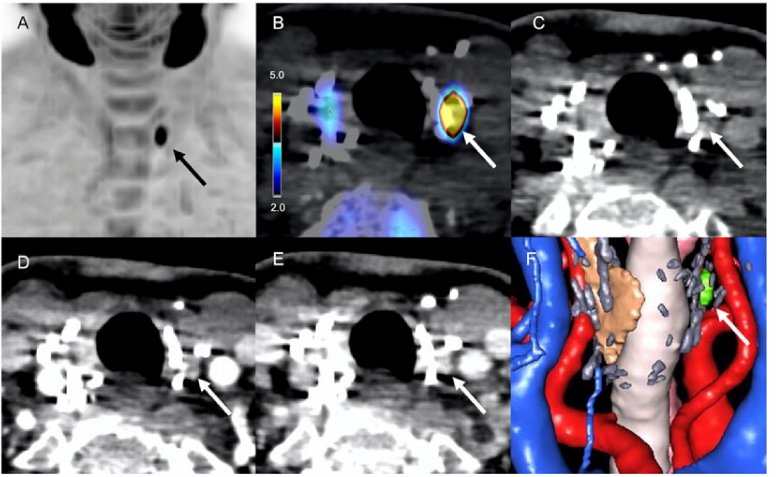
Figure 1. 18 F-FCH PET/CT, 4D-CT and 3D-virtual neck exploration of a 74-year-old woman with recurrent pHPT and a history of left thyroidectomy and removal of the upper right hyperplasic parathyroid gland. From left to right, top to bottom: lower left adenoma (black and white arrows) with high focal accumulation of 18F-FCH (( A ) anterior view of maximum intensity projection, ( B ) axial PET/CT image, SUVmax = 9.67), spontaneous density of 71 HU ( C ) no contrast enhancement on arterial-phase CT (( D ) density of 71 HU), delayed enhancement at the late venous phase (( E ) density of 140 HU), 3D-virtual neck exploration ( F ).